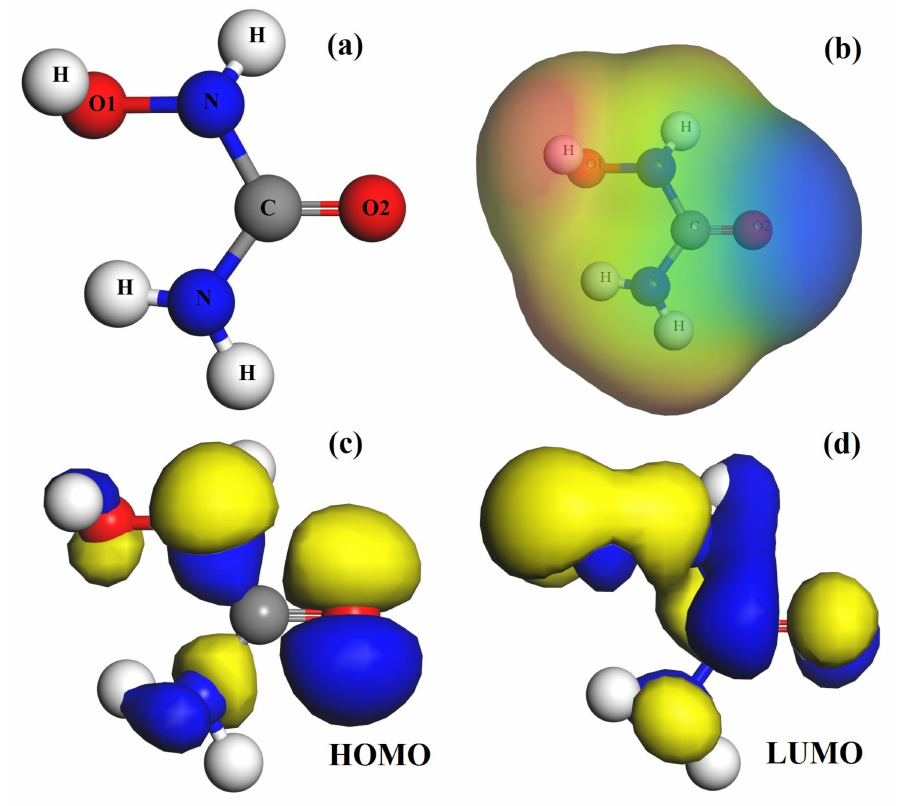
Figure 1. The optimized structure of hydroxyurea (HU) drug ( a ), and the molecular electrostatic potential (MEP) ( b ), HOMO ( c ) and LUMO ( d ) profiles of HU. Here, in the MEP plot the blue and red colors correspond to more negative and positive electrostatic potentials regions,